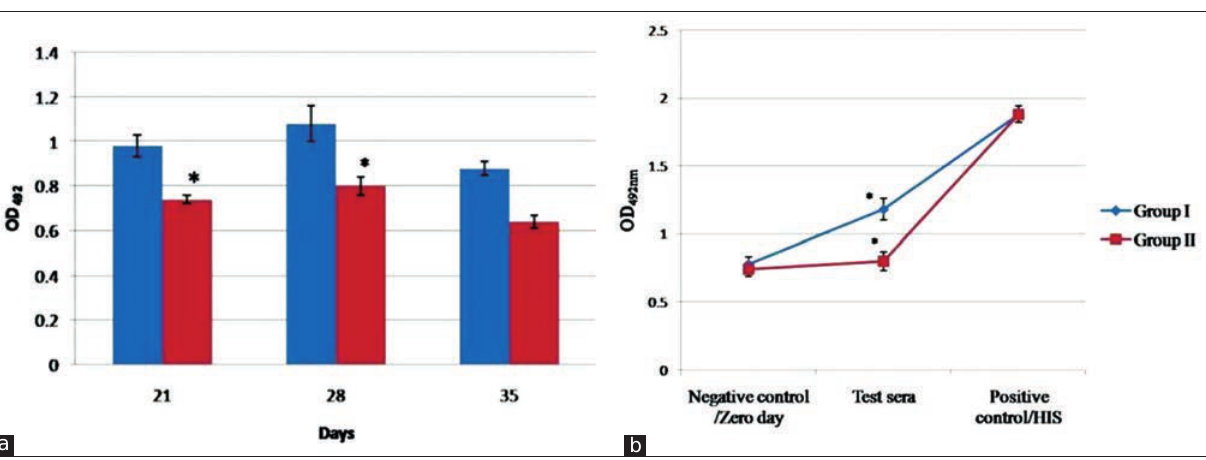
Figure-8: (a) Mean ± standard error absorbance at 492 nm wavelength enzyme-linked immunosorbent assay (ELISA) reading to compare immune response between groups at different time interval, *differ significantly (p<0.001) from immune response of Group I, (b) mean ± standard error absorbance at 492 nm wavelength ELISA reading to compare immune response between treatment groups (decellularized) and native fish swim bladder (hyper immune serum [HIS]), *differ significantly (p<0.001) from